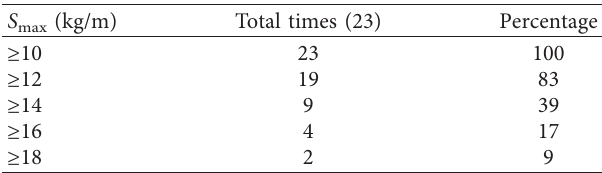
Table 11: Distribution of percentages of prediction index S 1max